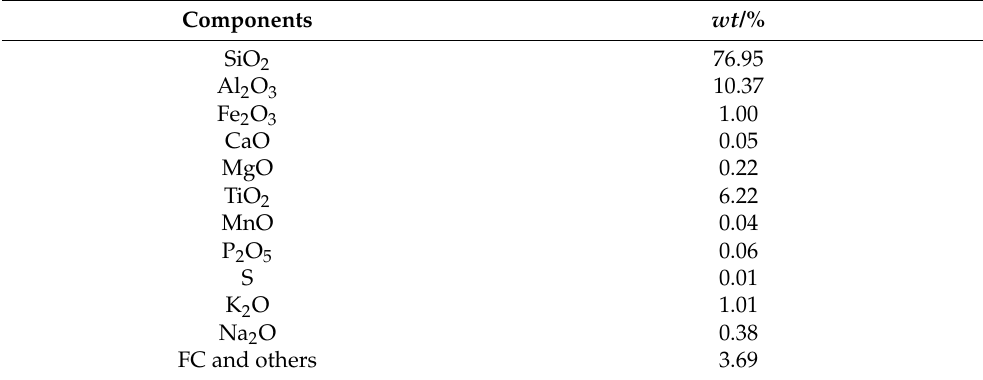
Table 2. Main components of the residue.